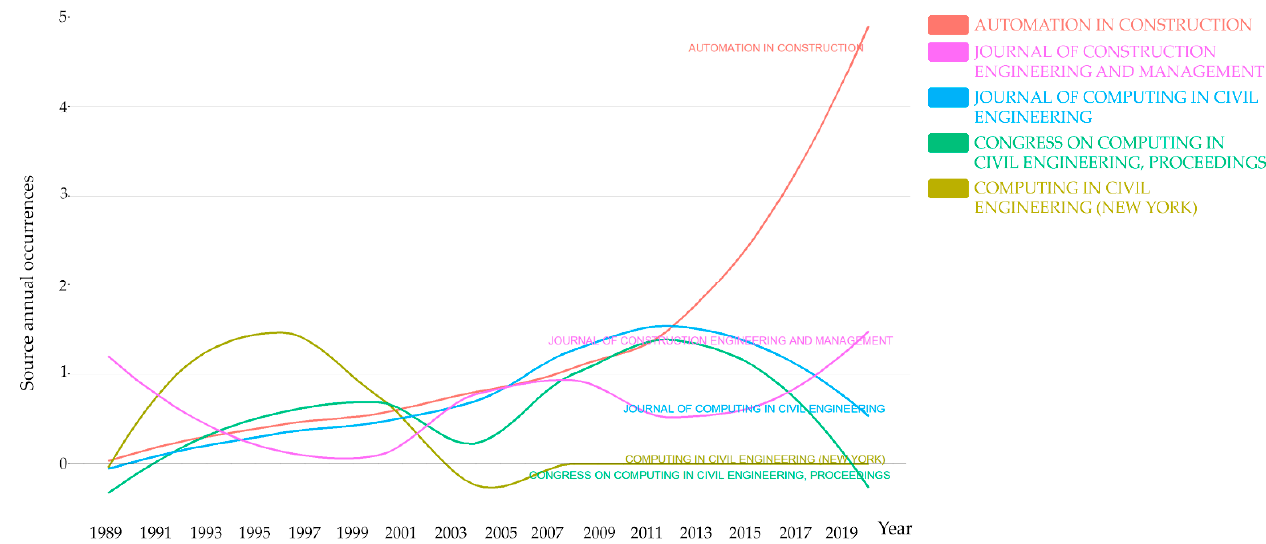
Figure 15. Source trend dynamics. Software: BiblioShiny version 3.0.